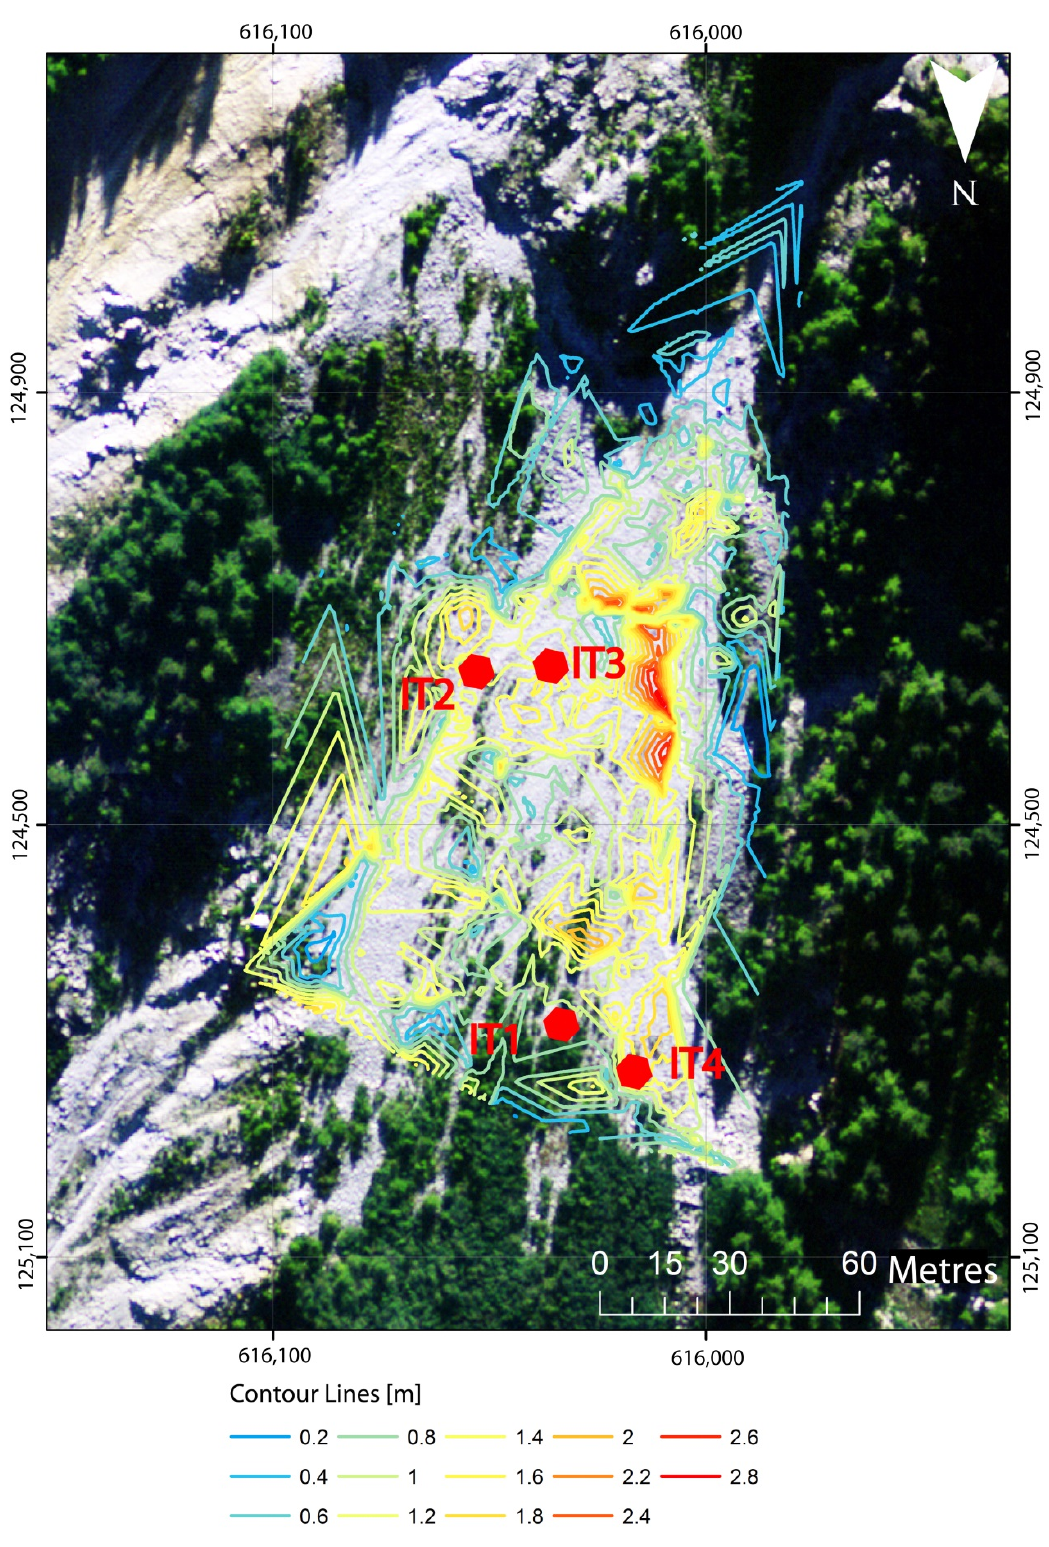
Figure 10. Contour lines of depth to bedrock in metres.